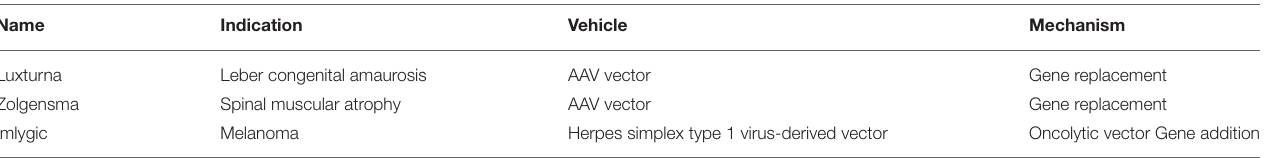
TABLE 1 | Commercial in vivo gene therapy